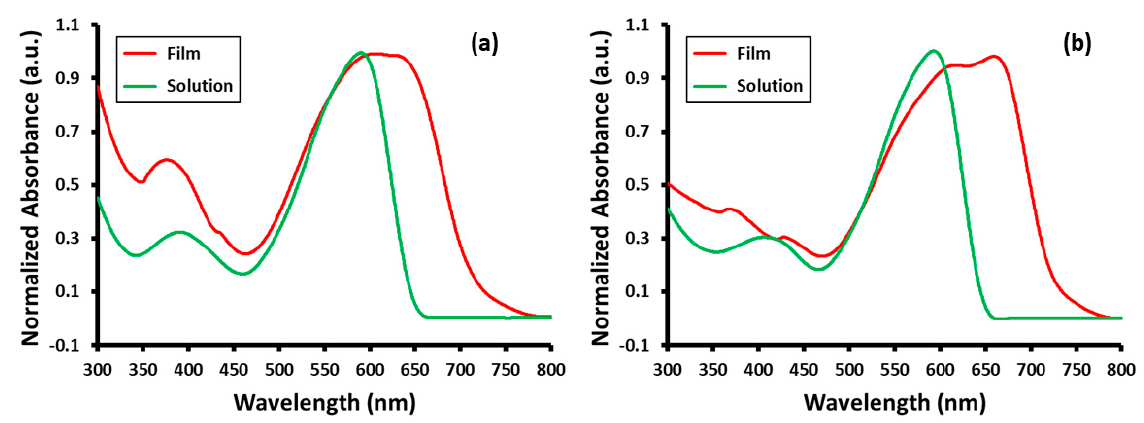
Figure 1. UV–VIS absorption spectra of ( a ) TDPP-T and ( b ) TDPP-EDOT in chloroform solution and thin films.